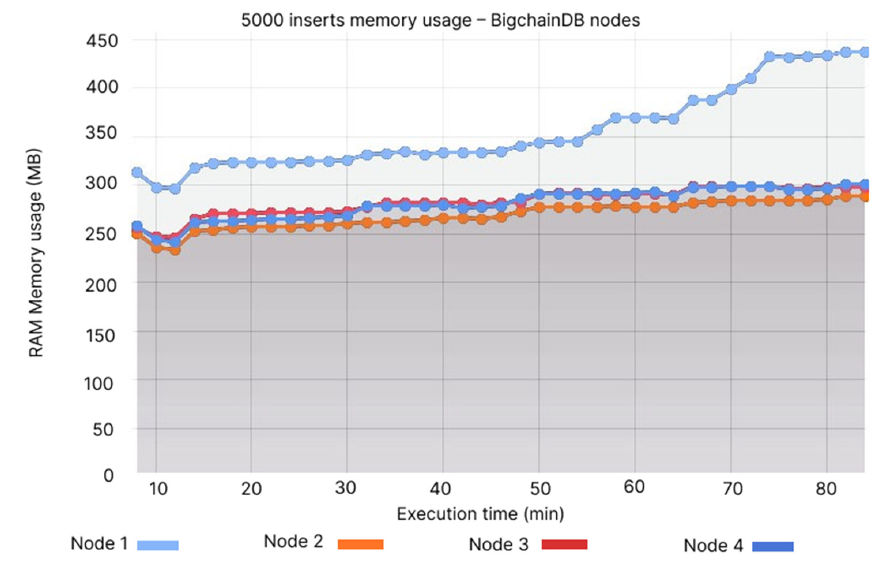
Figure 12. 5000 inserts memory usage—BigchainDB nodes.